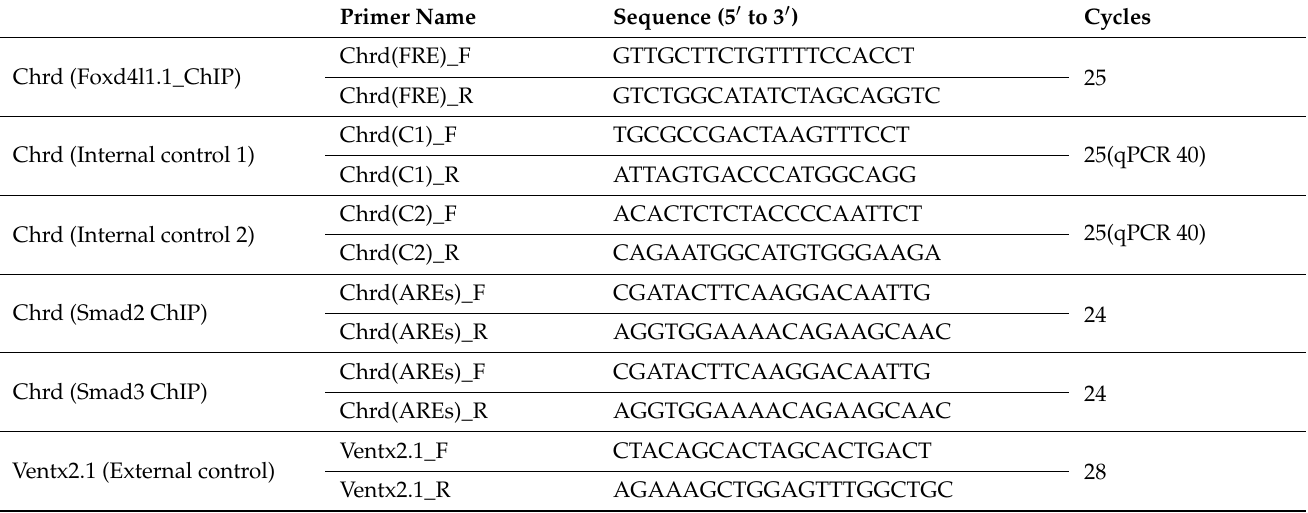
Table 5. Primers used for ChIP-PCR